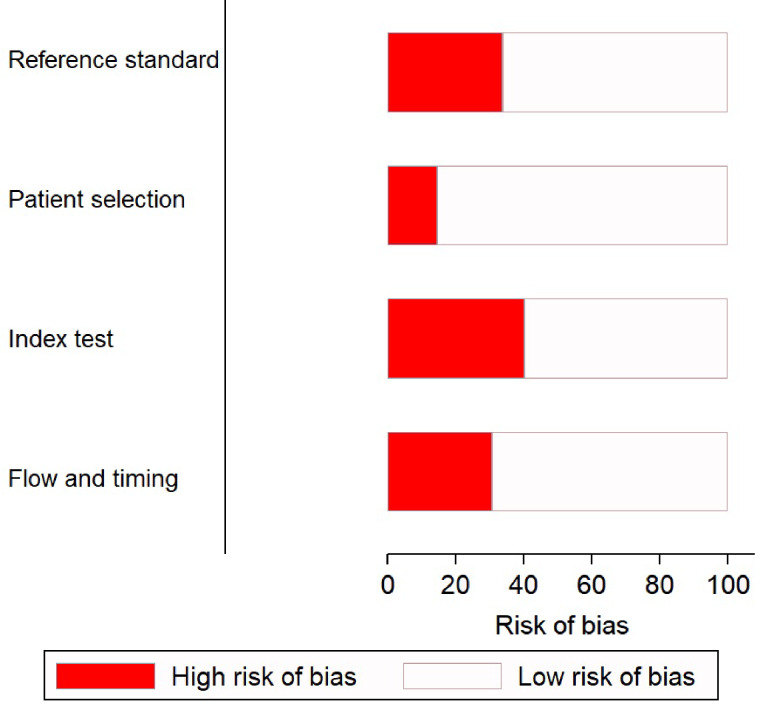
Quality assessment of the included studies (n = 45) using QUADAS-2 tool.